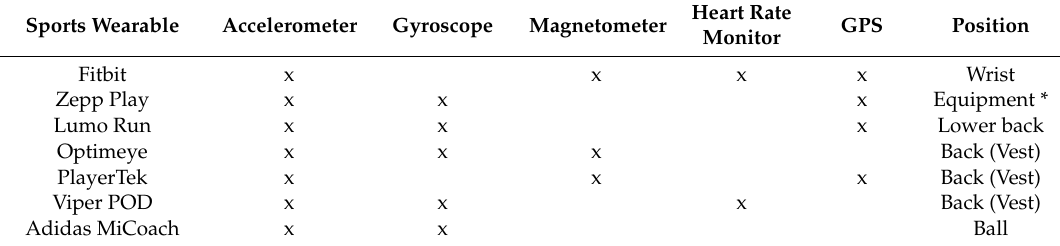
Table 5. Sensors found in consumer wearable technology for sport; data taken from Vandrico [54].